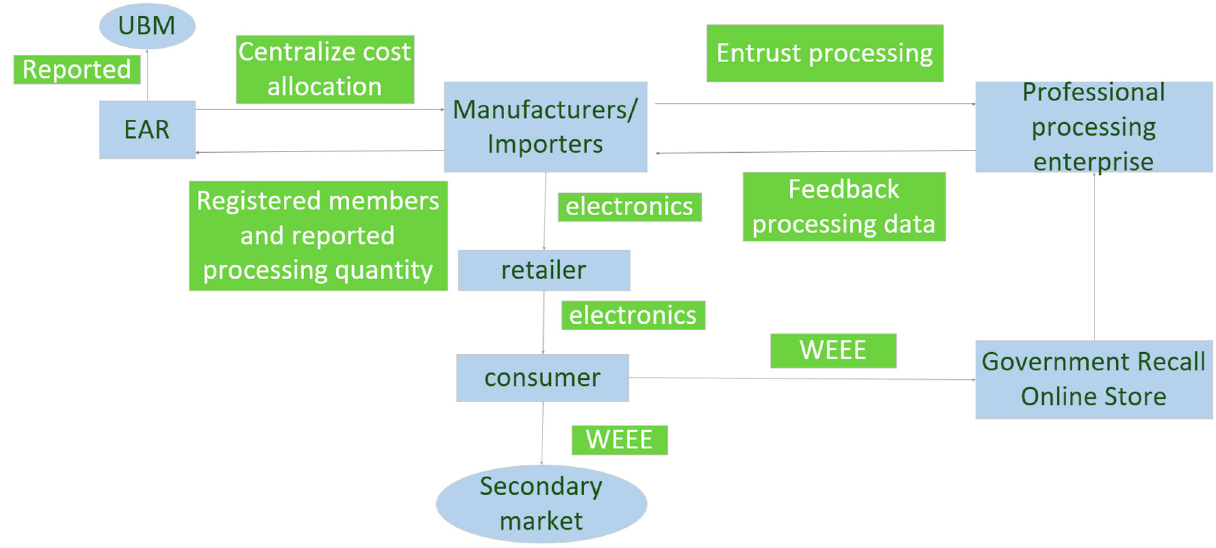
Figure 1. Operation mode of the fund policy in Germany (concluded from